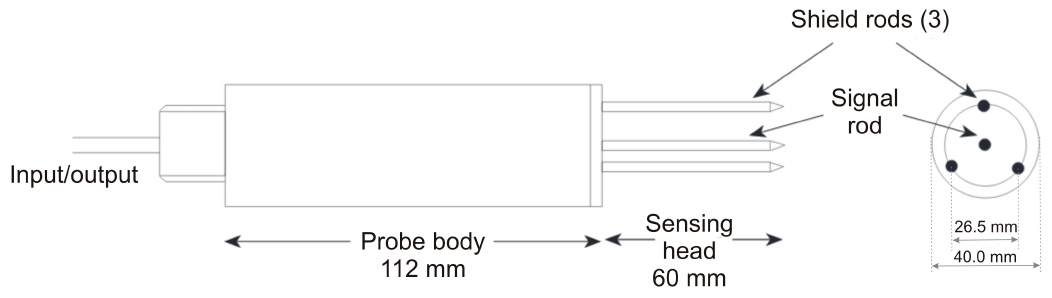
Figure 1. ThetaProbe scheme and dimensions [33].